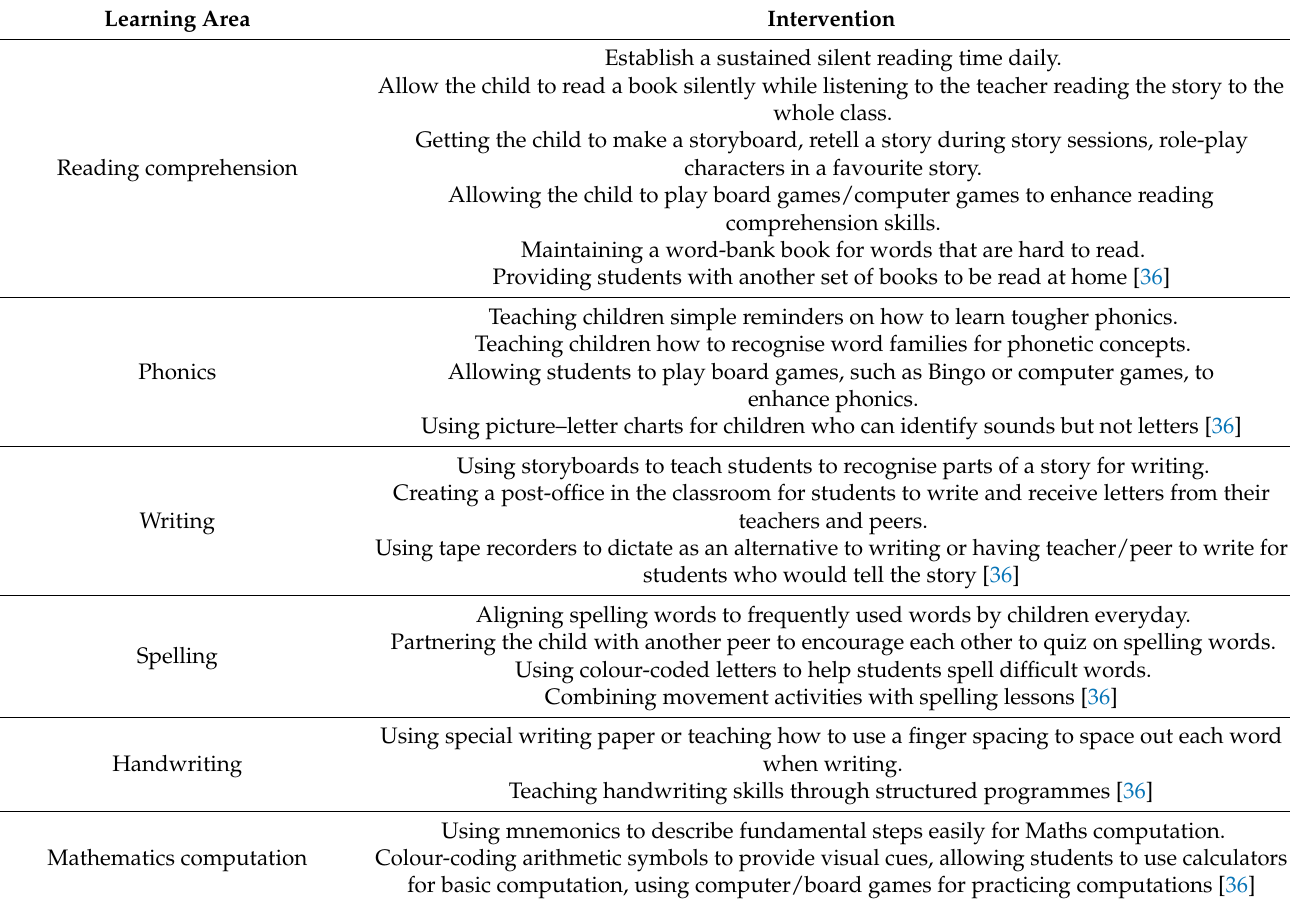
Table 1. Individualised educational practices in schools for children with ADHD.